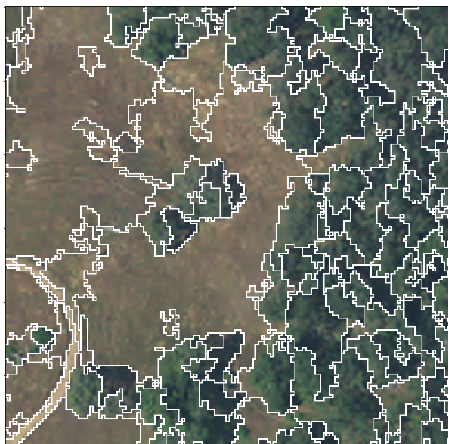
Figure 10. Object-based Image Analysis (OBIA) segmentation result for one of ELD’s test rectangles, showing a grouping of similar pixels merged into objects separated by white